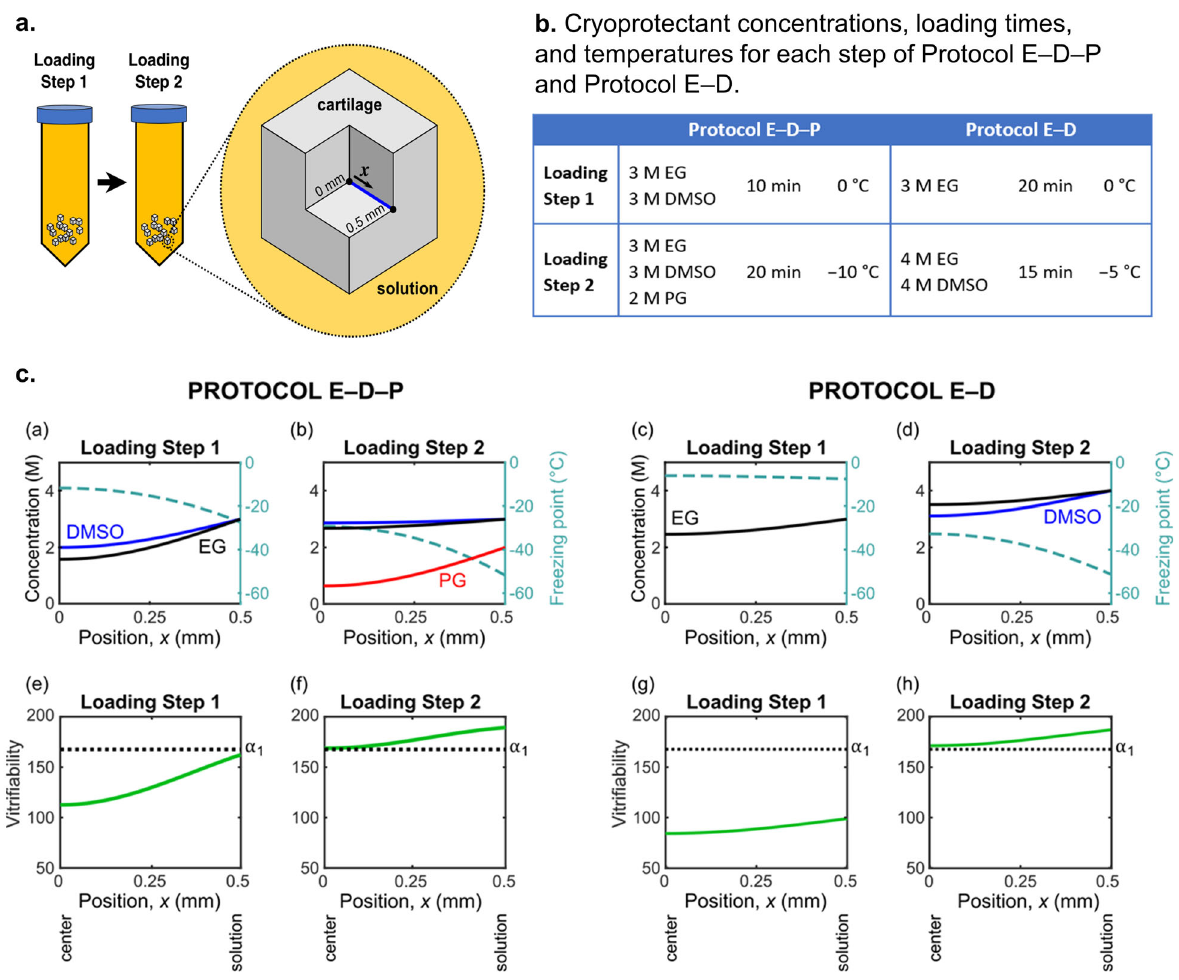
Fig. 1 Overview of theoretical calculations. a Schematic of the 1 mm 3 articular cartilage cubes. For our theoretical calculations, we consider a one-dimensional line for diffusion with length 0.5 mm extending from the center of the cube to the edge of the cube that is in contact with the cryoprotectant solution. b Summary of cryoprotectant concentrations, loading times, and temperatures for each step of Protocol E – D – P and Protocol E – D. Each protocol consists of two steps, with the second step introducing an additional cryoprotectant at a reduced temperature. c Calculations of the spatial distribution of cryoprotectant concentration, solution freezing point, and vitri fi ability at the end of each loading step. For these calculations, we used Fick ’ s law of diffusion, the multisolute osmotic virial equation combined with the Gibbs – Duhem equation 26,27,30 , and a statistical model of vitri fi ability 25 . In (e) – (h), α 1 indicates the minimum vitri fi ability score required for vitri fi cation under the experimental conditions described in Weiss et al. 25 .